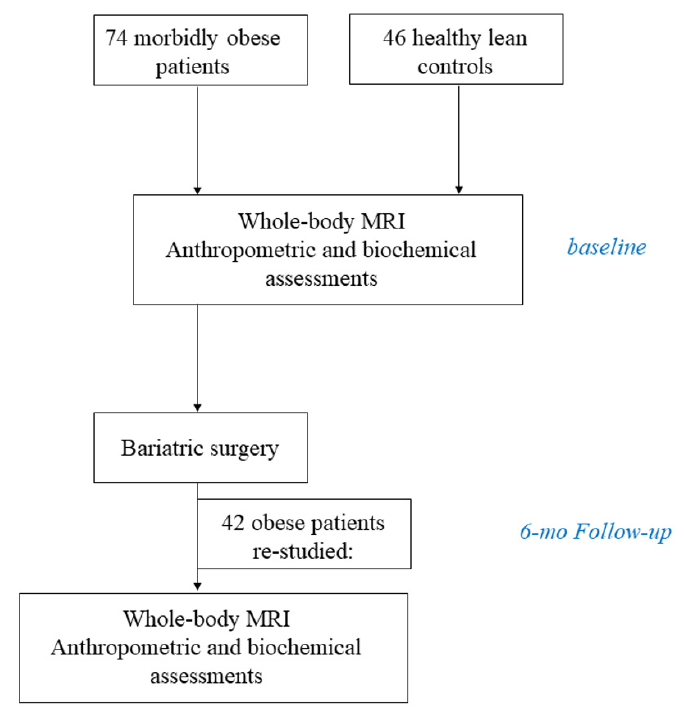
Figure 3. Flow chart of the